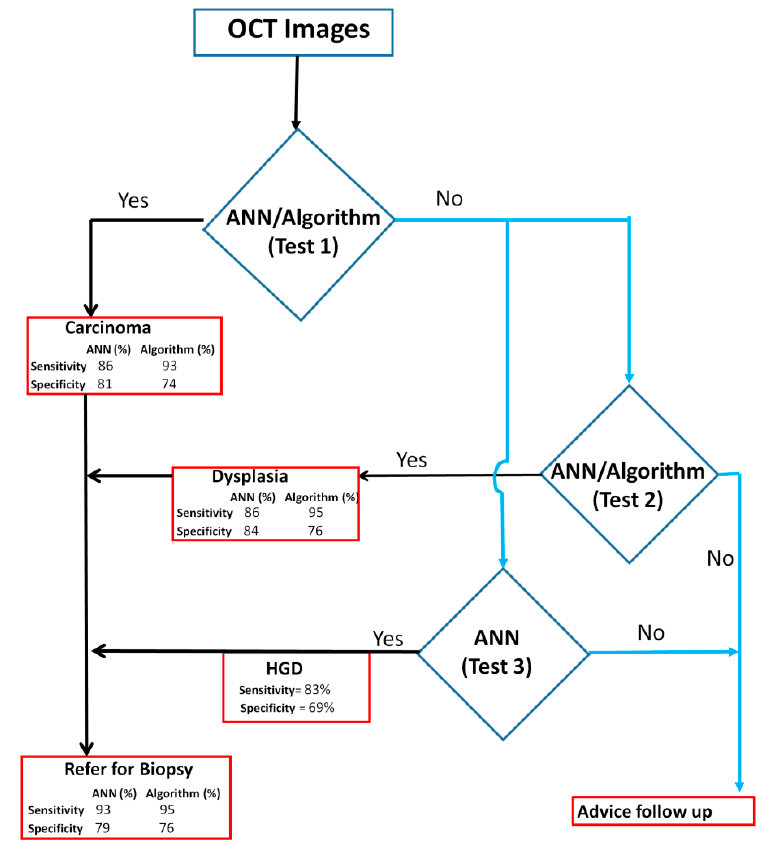
Figure 7. Decision tree for incisional biopsy from OCT diagnostic system. The decision tree consists of Test 1, which will identify OSCC patients. Test 2 and Test 3 can be used to identify patients with dysplasia and high ‐ grade dysplasia (HGD) respectively. The combined sensitivity of these three tests ranges between 93–95% for delineating oral cancer and dysplasia. This decision tree can be used to triage high ‐ risk patients in oral cancer screening camps. ANN: Artificial neural network.